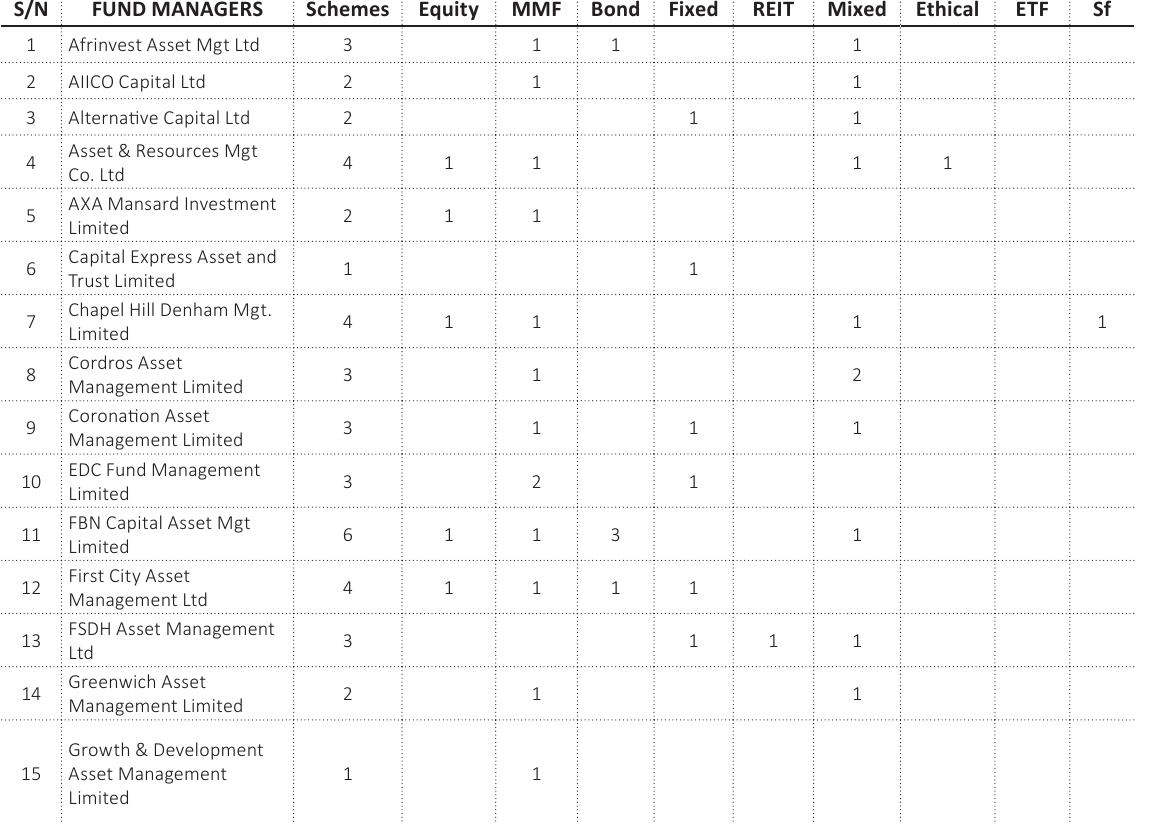
Table 1. Fund managers, schemes, and net asset value as at May 31, 2019